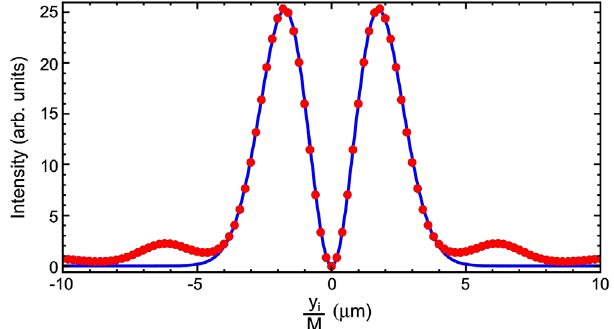
FIG. 7. Calculated vertical SPF profile (points) and fit (solid line) according to Eq. (11). The SPF calculation parameters are those of Fig. 2 for ideal focusing ( Δ a ¼ 0 ).